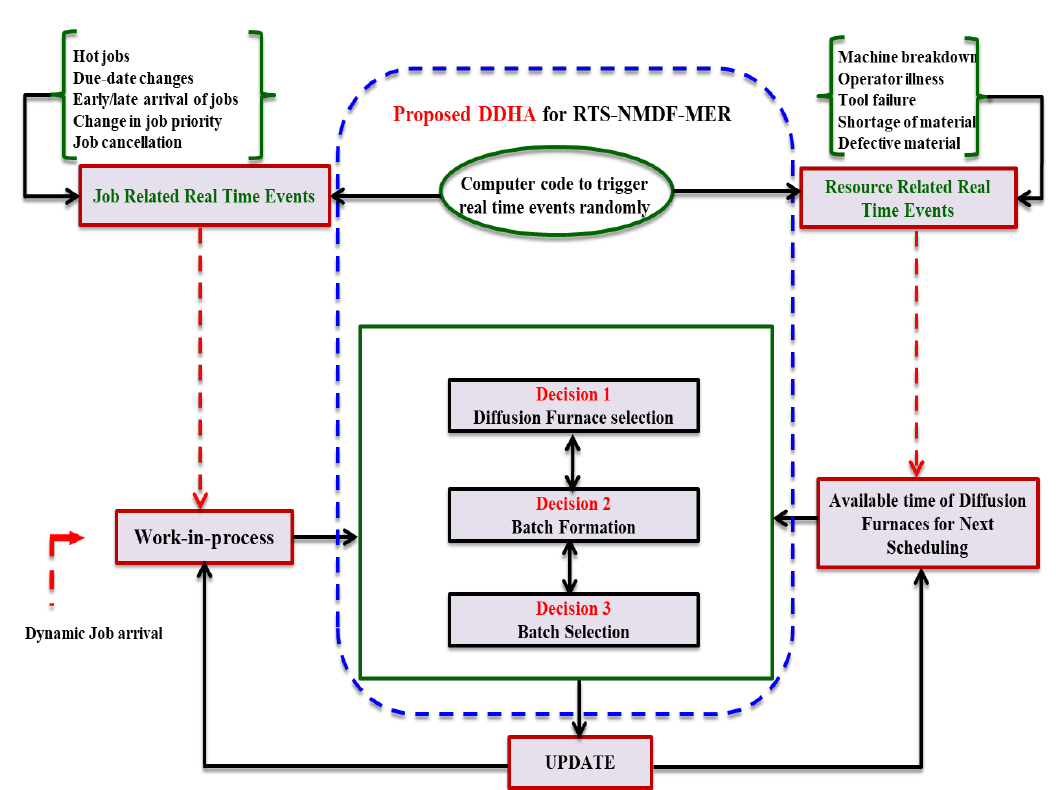
Figure 1. A solution framework for the proposed DDHA for